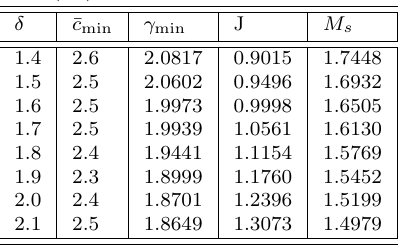
Table 2: PID controller, Eq (26), with the proposed δ - tuning rules in Alg. 2.1 and Eq. (27) for a DIPTD process, h p ( s ) = K e − τs , with K = 1 s 2 and time-delay, τ = 1. Shows ¯ c min , γ min = arg min ¯ c,γ J , with prescribed δ . Objective in Eq. (44).